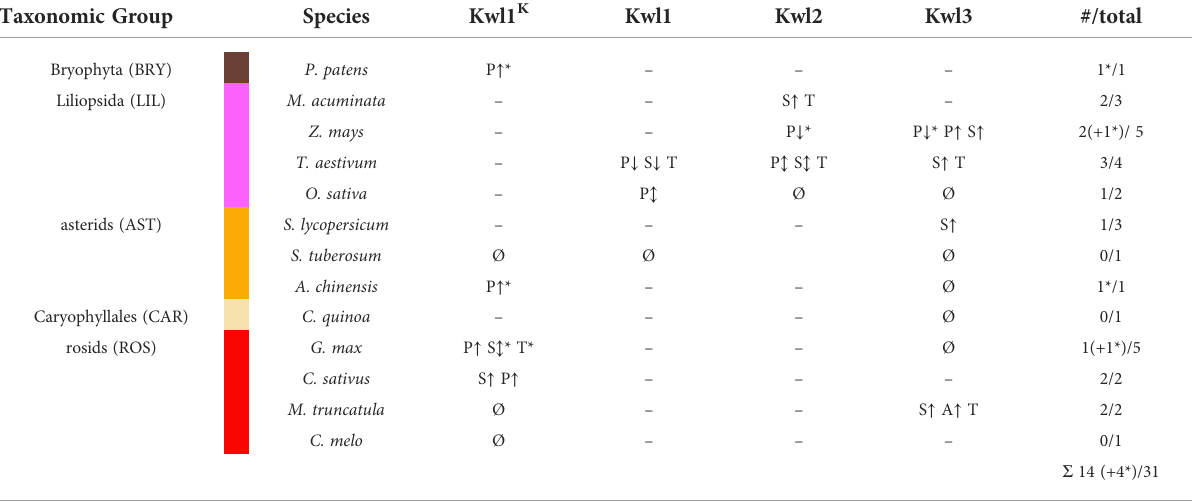
TABLE 1 Overview of strongly expressed and signi fi cantly regulated Kiwellin groups among all species with RNA-seq data sets. Taxonomic Group